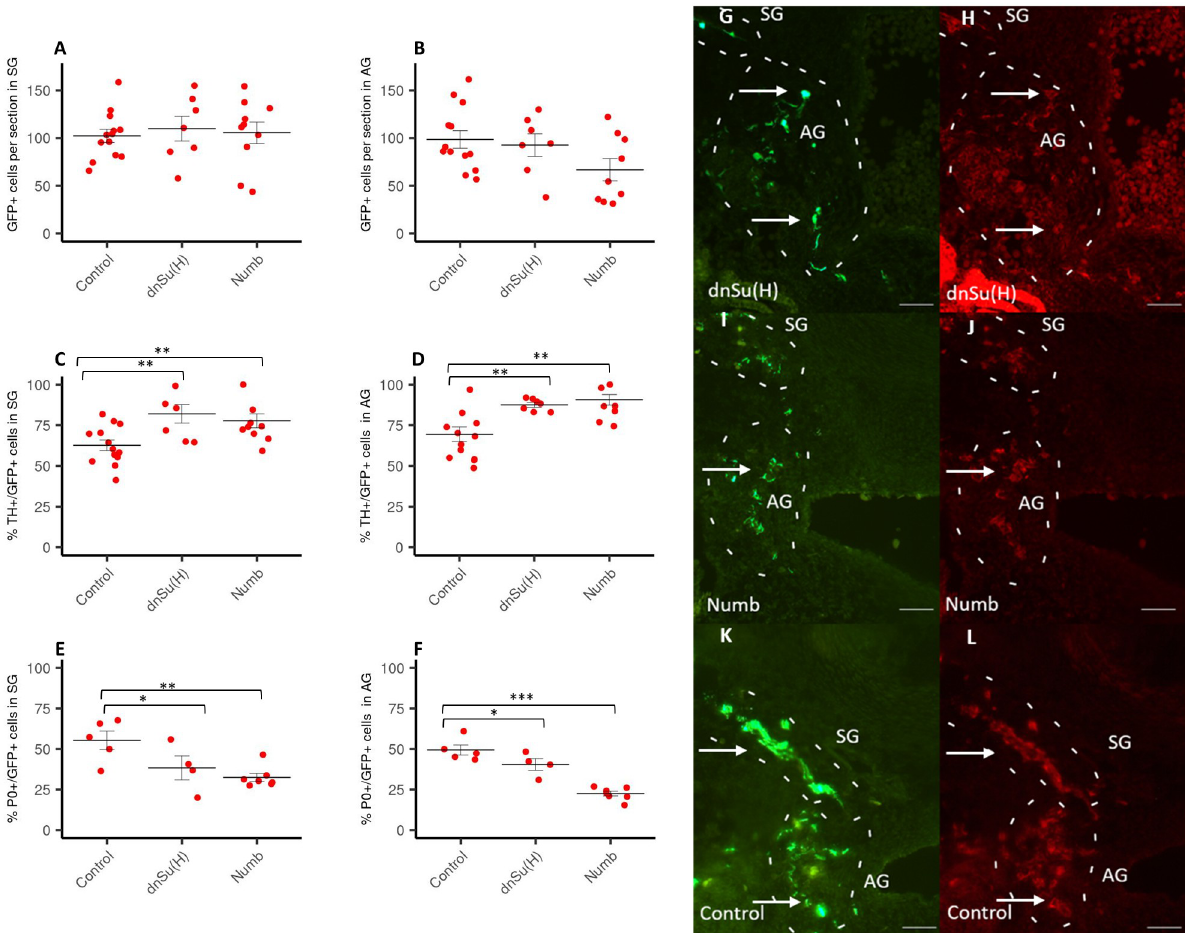
Fig 1. Analysis of GFP+, TH+/GFP+ and P0+/GFP+ cells in SG and AG following downregulation of Notch. Amount of GFP-positive cells per section (% of control) in sympathetic ganglia (SG) (A) and the adrenal gland (AG) (B) of E6 chick embryos after electroporation with dnSu(H) or Numb at E2. Amount of TH+/GFP+ cells (% of the total number of GFP-positive cells) in sympathetic ganglia (SG) (C) and the adrenal gland (AG) (D) of E6 chick embryos after electroporation with dnSu(H) or Numb at E2 (control n = 13, dnSu (H) n = 7, Numb n = 10). Amount of P0+/GFP+ cells in SG (E) and AG (F) of E6 chick embryos after electroporation with, dnSu(H) or Numb at E2 (control n = 5, dnSu(H) n = 4, Numb n = 7). Data are presented as mean +/- S.EM. � p � 0.05; �� P � 0,01; ��� P � 0,001; n: number of experimental animals. Photomicrographs showing GFP and P0-positive cells in SG and the AG (G-L) of E6 chick embryos after electroporation with dnSu(H) (G, H), Numb in (I, J) and control (K, L) at E6. Embryos were immnunostained using antibodies against GFP, (G, I, K) and P0 (H, J, L). The values used to build the graphs in S1 File. Scale bar: 100 μ